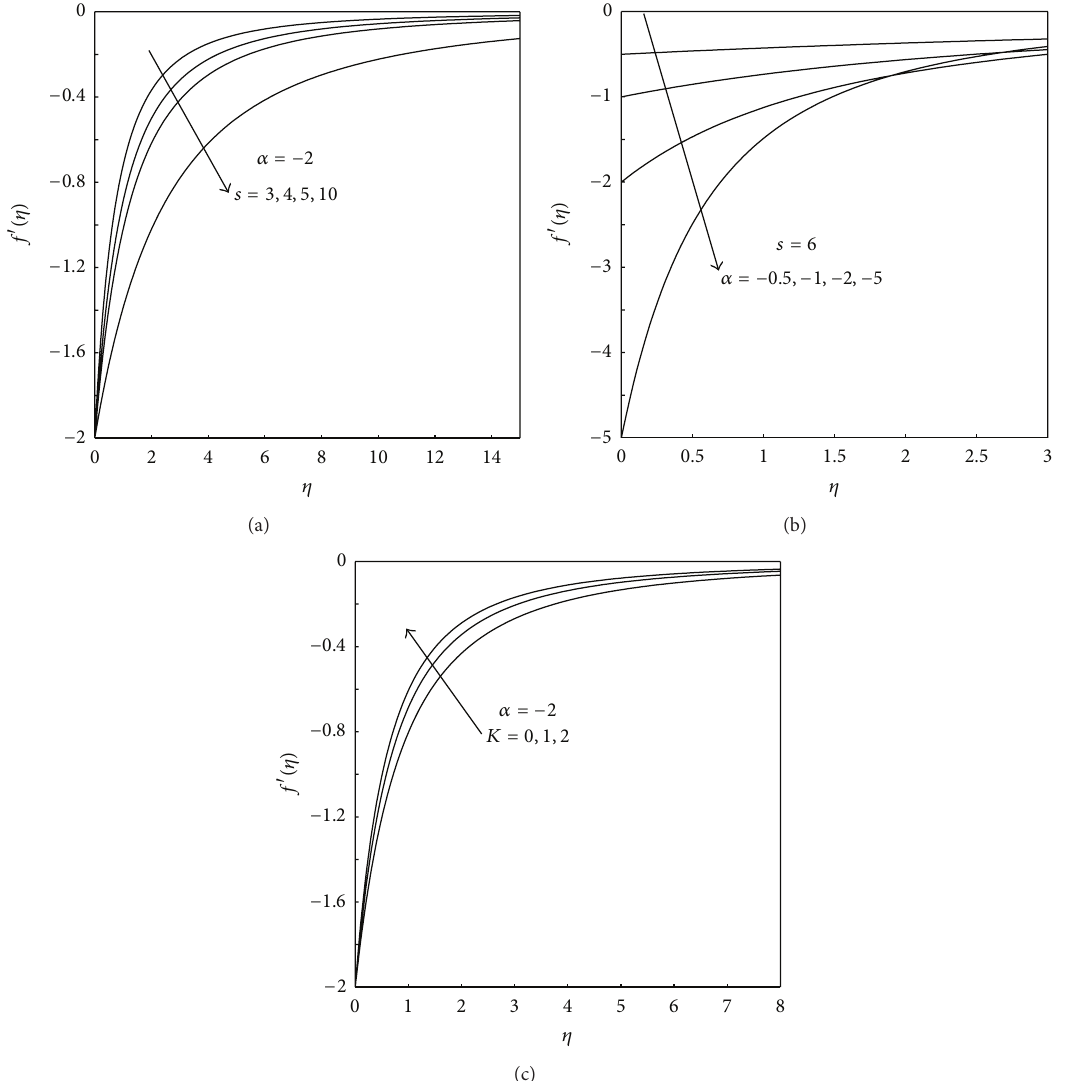
Figure 4: (a) Velocity profiles for a shrinking sheet under different values of mass suction parameter. (b) Velocity profiles under different values of shrinking sheet strength with mass suction. (c) Velocity profiles for a shrinking sheet under different values of permeability